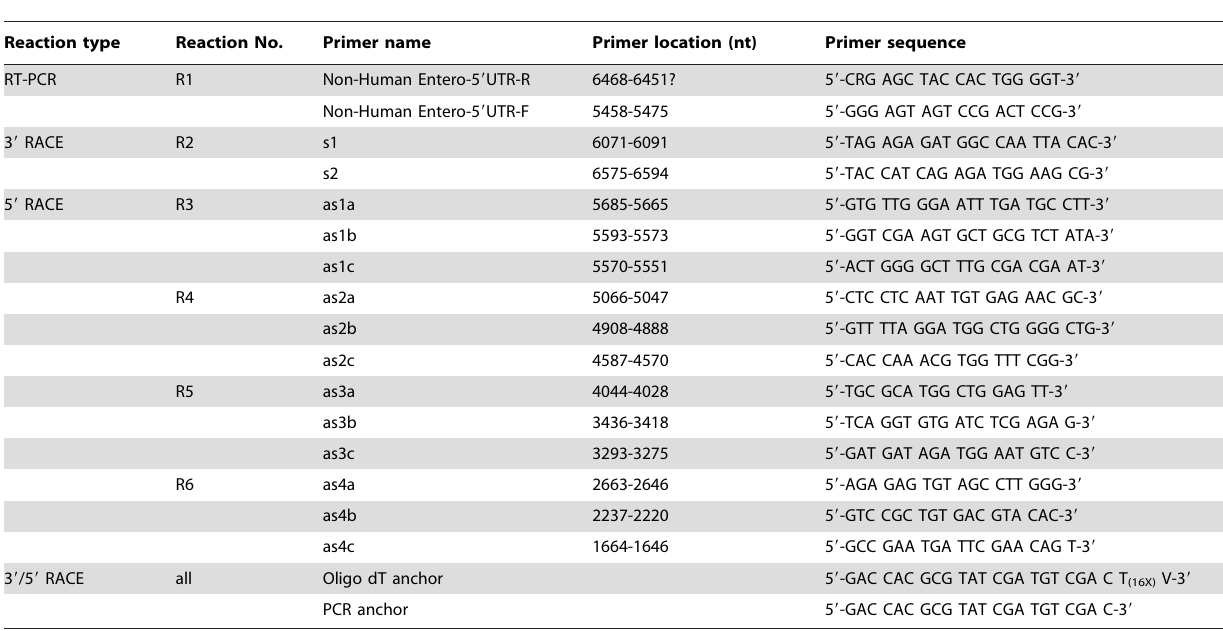
Fig. 1C shows the positions of Reaction No. R1-R6 in genome acquisition strategy using 3 9 /5 9 -RACE method. doi:10.1371/journal.pone.0029145.t001 PLoS ONE |